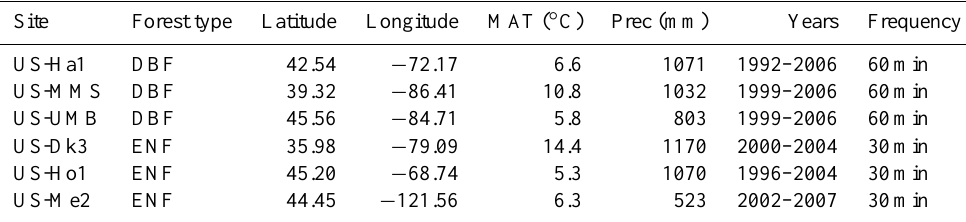
Table 1. Site information for the three deciduous broadleaf forest (DBF) and three evergreen needleleaf forest (ENF) flux towers, including mean annual temperature (MAT) and annual precipitation (Prec).